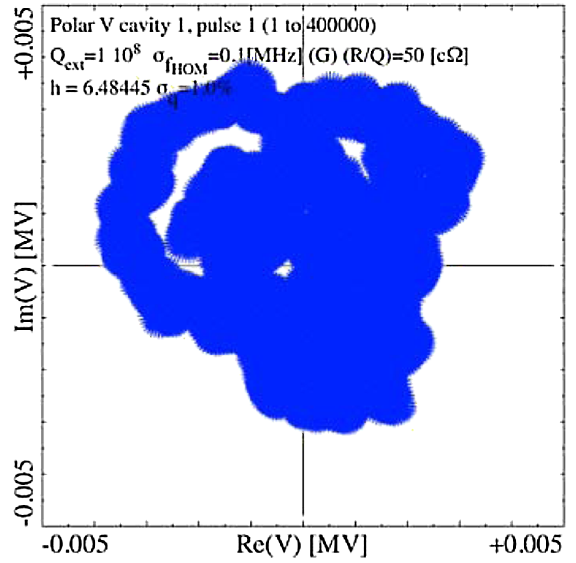
FIG. 68. (Color) Polar display of the cavity voltage above.